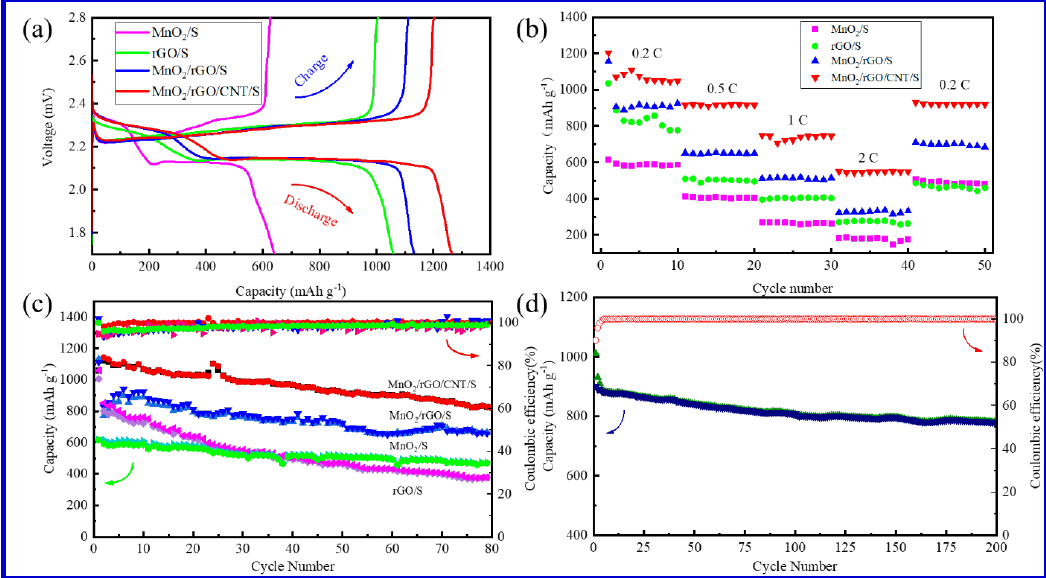
Figure 4. Charge–discharge curves ( a ); rate performance ( b ); cycling performance and coulombic efficiency ( c ) of rGO/S, MnO 2 /S, MnO 2 /rGO/S, and MnO 2 /rGO/CNTs/S ; long cycle performance of MnO 2 /rGO/CNTs/S ( d ).